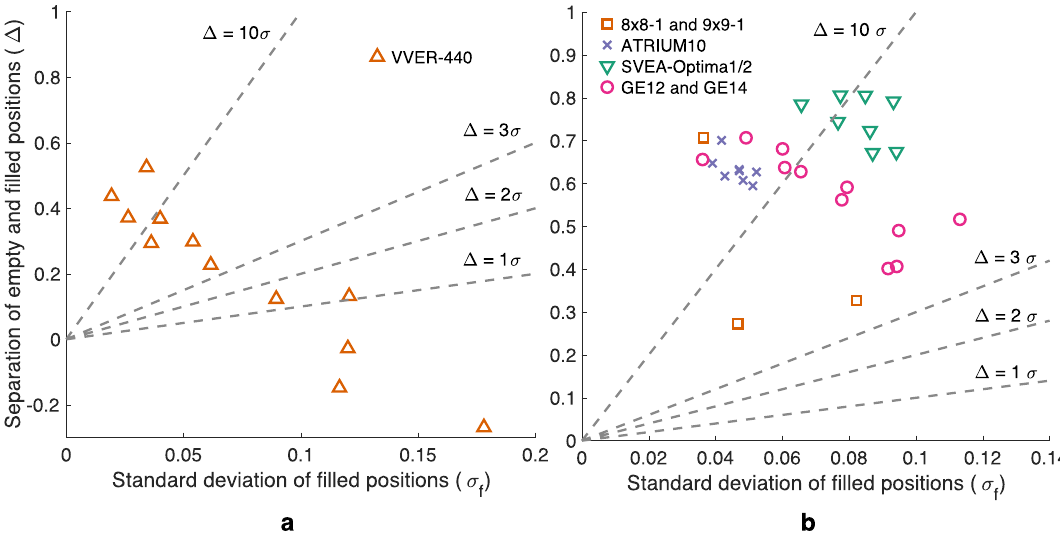
Figure 3. Image quality index plots for images from Loviisa 2020 ( a ) and Olkiluoto 2021 ( b ) measurement campaign results. Different fuel types are denoted with varying colors and markers. Note that the Loviisa 2020 results are from a gamma energy window of 600–700 keV and the Olkiluoto 2021 results from a 650–700 keV